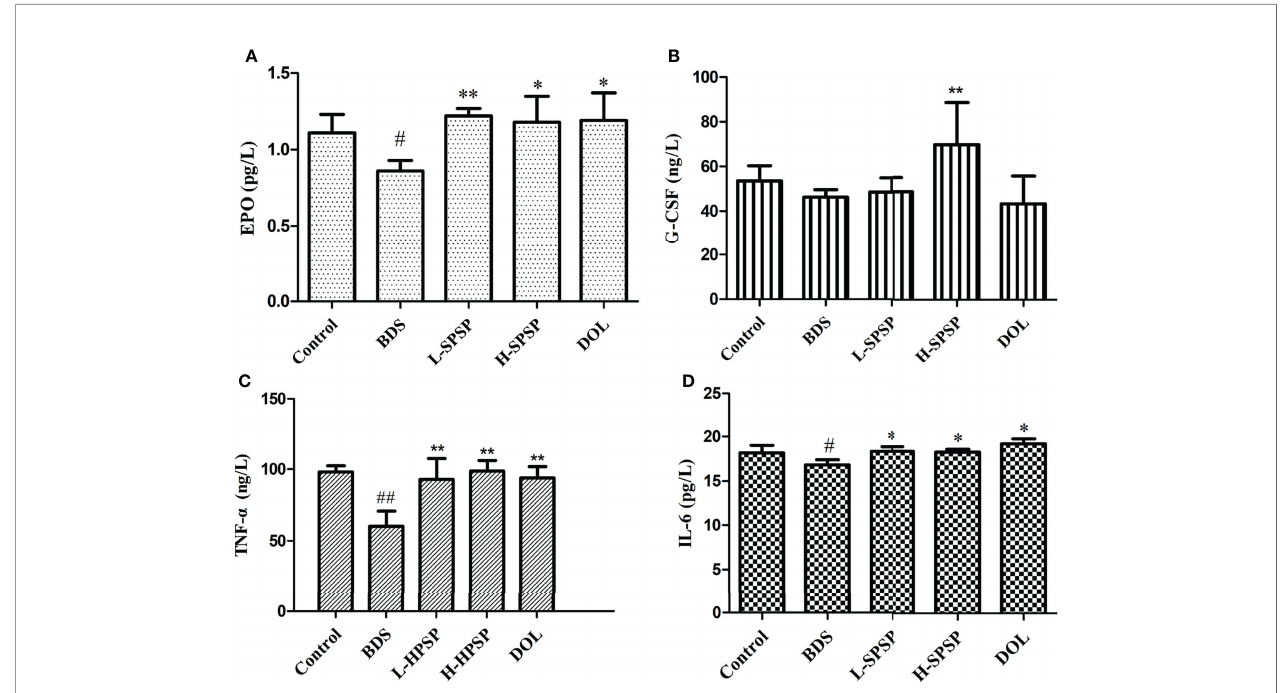
FIGURE 5 | The effect of SPSP on hematopoietic functions (A, B) and immunomodulatory cytokines (C, D) in BDS mice. (A) The level of EPO. (B) The level of G-CSF. (C) The level of TNF- a . (D) The level of IL-6. Each value is represented the mean ± SD (n = 3); # p < 0.05, ## p < 0.01 versus Control group. * p < 0.05, ** p < 0.01 versus BDS.